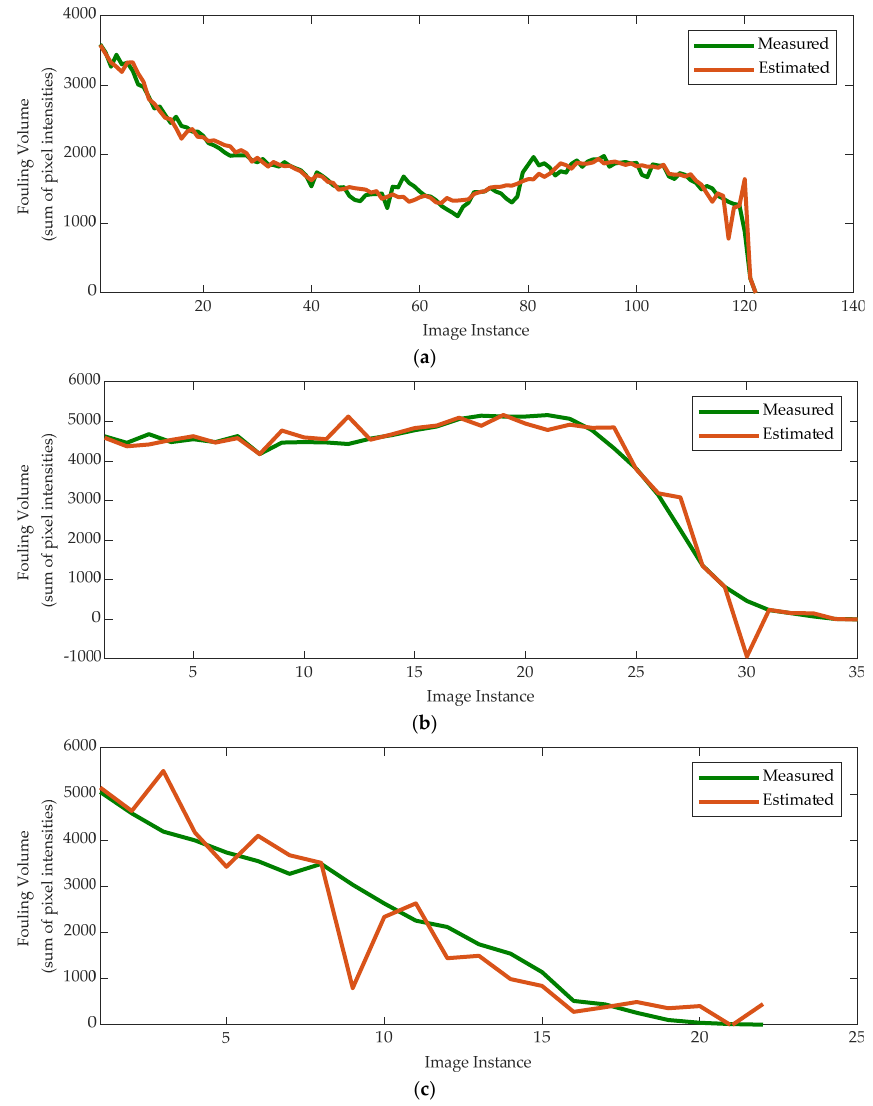
Figure 14. Measured fouling volume vs. NN estimations for gravy_cold_1 ( a ), malt_cold_2 ( b ), and tomato_cold_1 ( c ) tests.